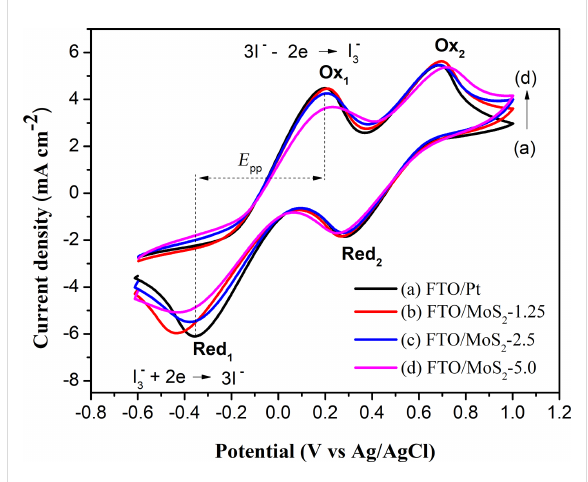
and 1T phases of MoS 2 (Figure 4b). The appearance of the J 1 ,